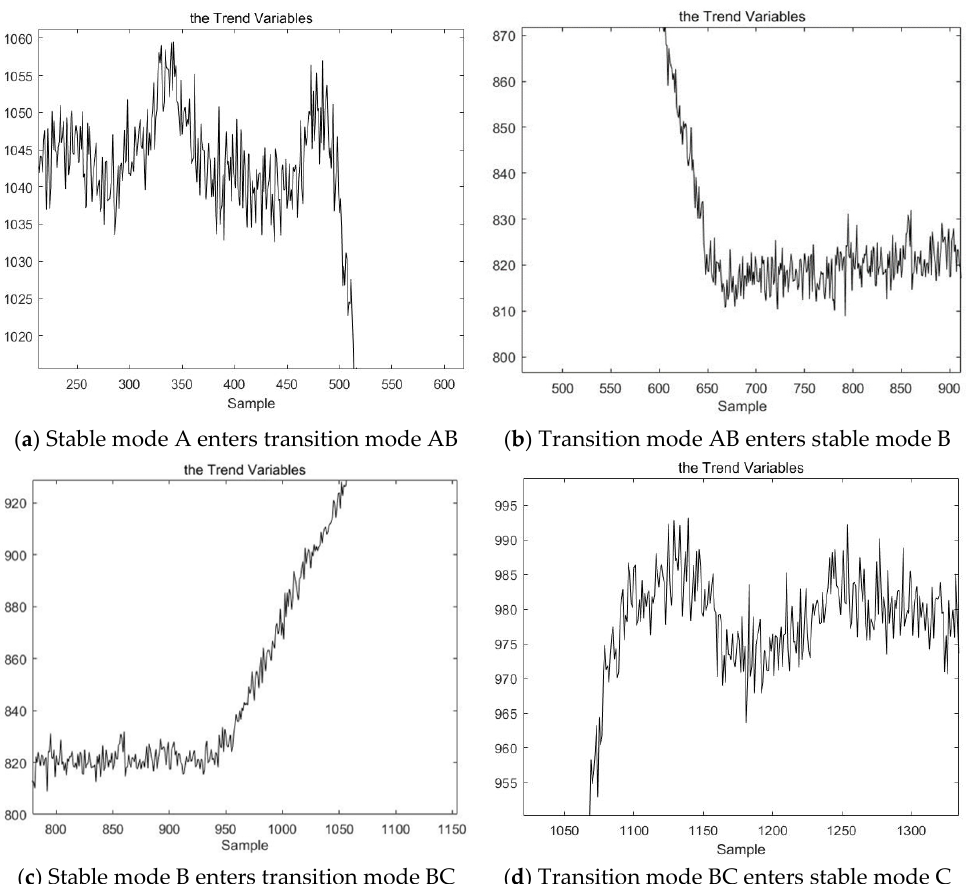
Figure 6. The local magnifications of the trend variable.